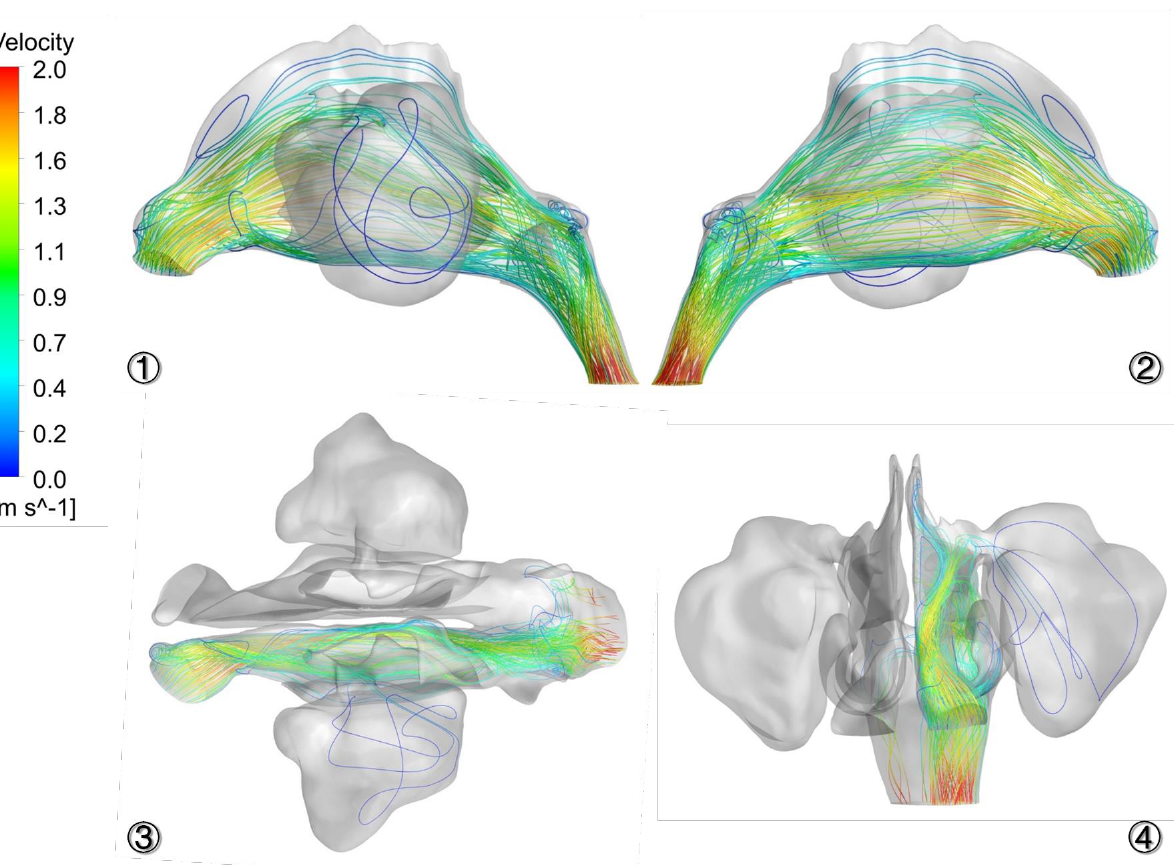
Figure 2. Airflow streamline track in the nasal cavity under the 15 L/min inspiratory condition